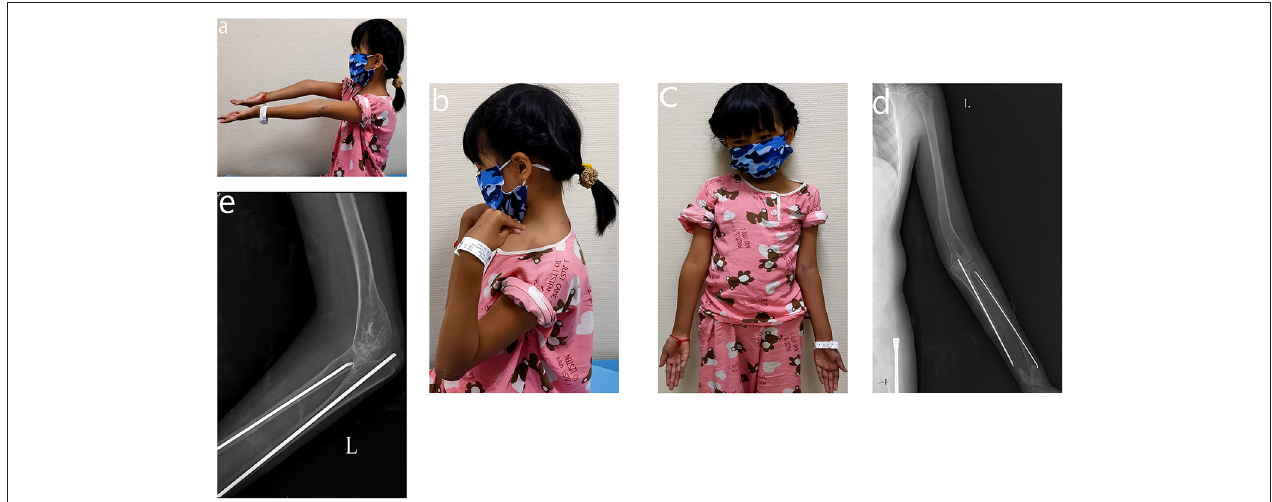
FIGURE 4 | Appearance and function of 18-month after plate removal. (a) Extension of the elbow joint. (b) Flexion of the elbow joint. (c) Appearance of upper extremity. (d) AP view of the left upper extremity. (e) Lateral view of the left elbow